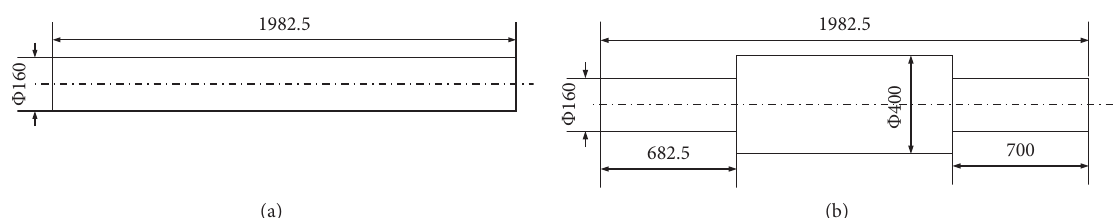
Figure 2: Model of lumped mass.